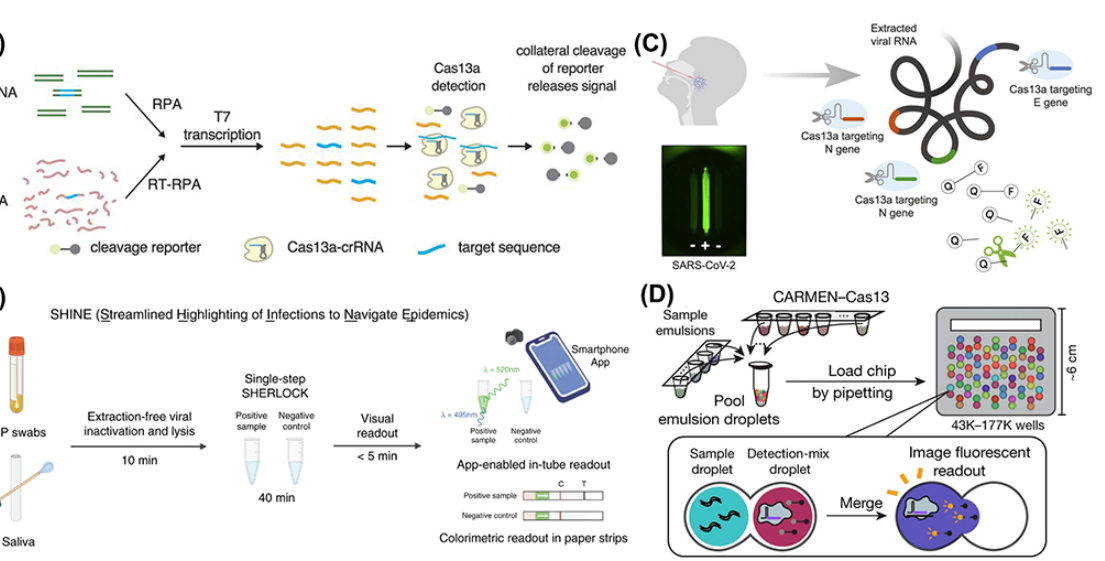
Figure 3. Schematic of different procedures of CRISPR-Cas13 based diagnostic methods: ( A ) schematic of SHERLOCK. Reprinted/adapted with permission from Ref. [31]. Copyright © 2022, American Association for the Advancement of Science. ( B ) schematic of SHINE. Reprinted/adapted with permission from Ref. [31]. Copyright © 2022, Springer Nature. ( C ) schematic of CRISPR ‐ Cas13 sys ‐ tem combined with mobile phone microscopy. Reprinted/adapted with permission from Ref. [34].